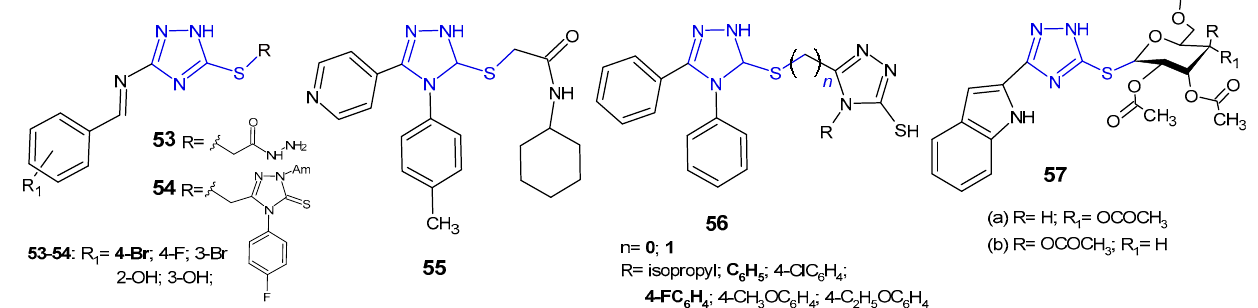
Figure 17. S-substituted 1,2,4-triazole-3-thioles with antibacterial activity.